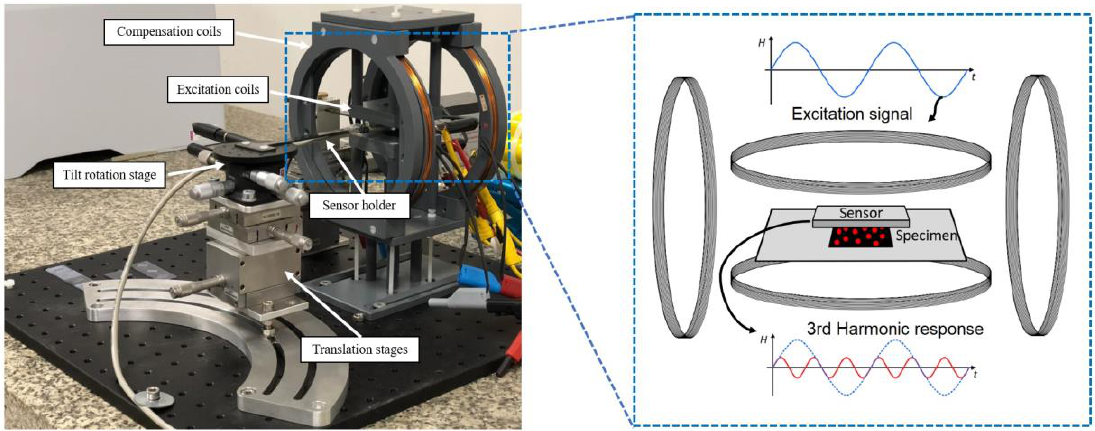
Figure 1. The magnetic particle imaging apparatus; the left side shows the fabricated setup and the right side depict a schematic diagram of the